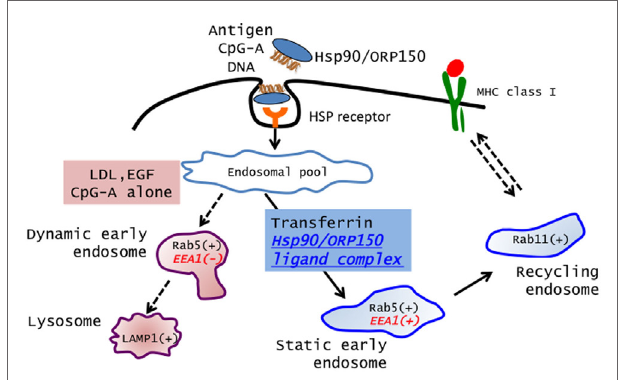
FiGURe 1 | extracellular Hsp90/ORP150 targets chaperoned molecules into static early endosome . Hsp90/ORP150–ligand complexes are preferentially targeted and retained in static early endosome (Rab5 + and EEA1 + ) but not in dynamic early endosome (Rab5 + and EEA1 − ).